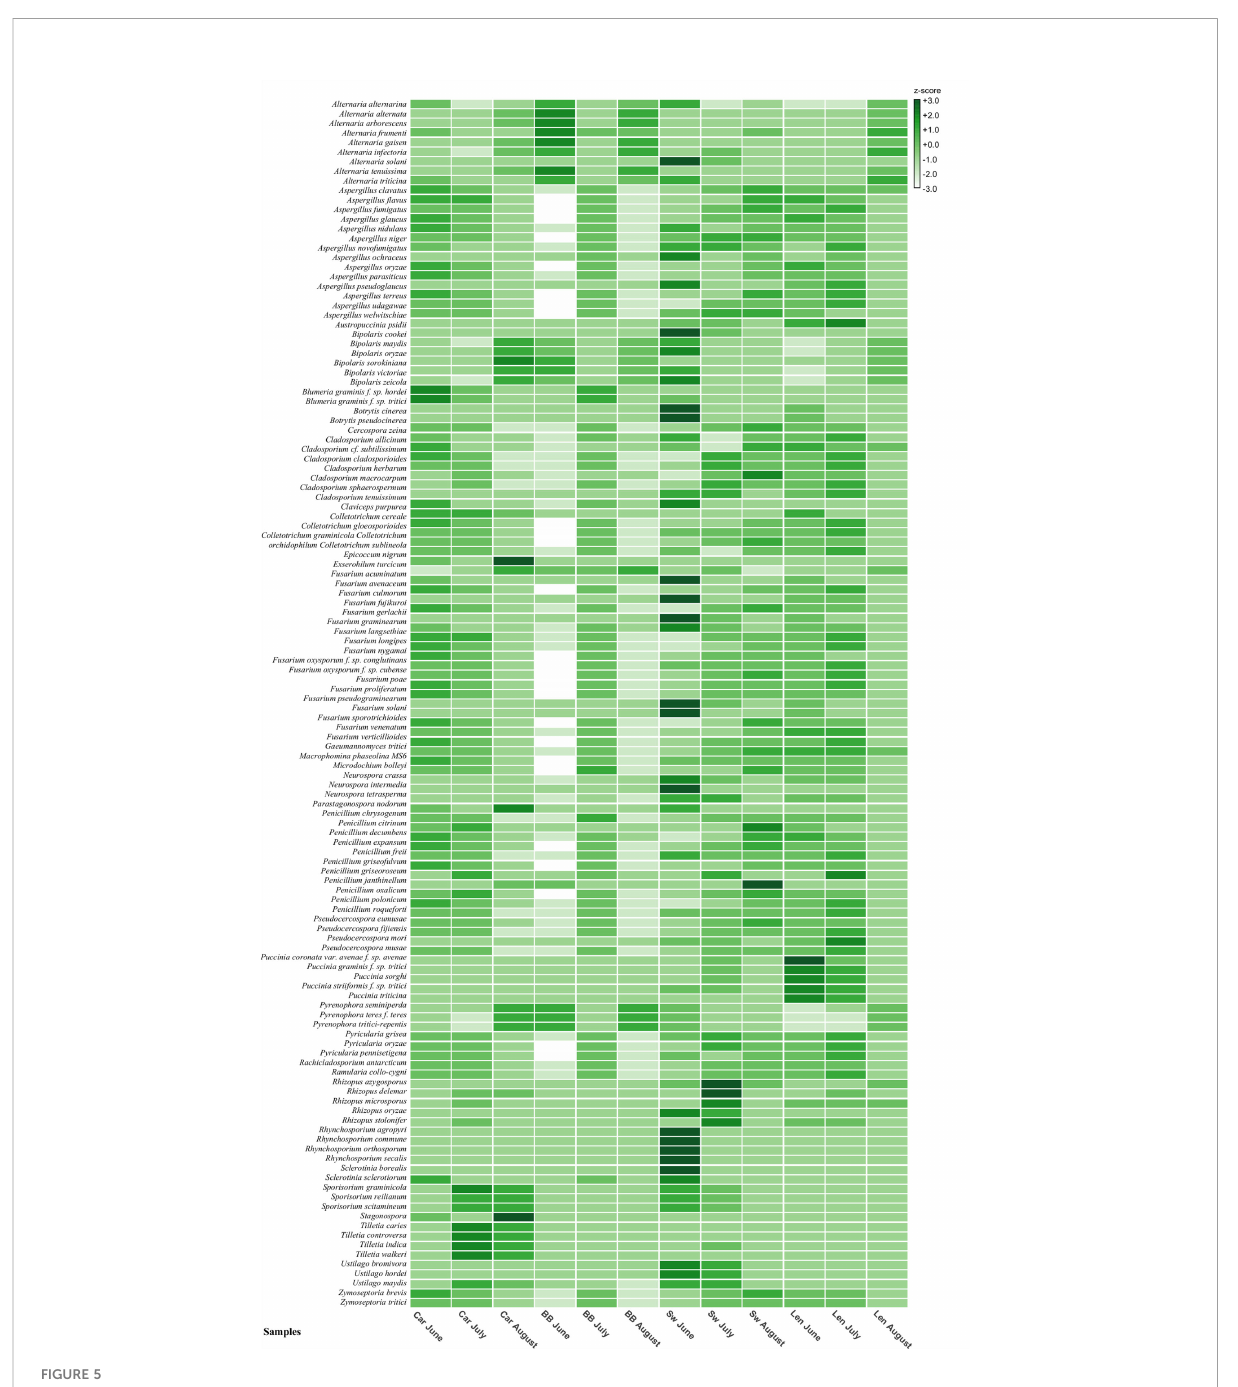
FIGURE 5 Heat map built in MEGAN 6 summarizing the 150 cereal fungal pathogens species hits recognized by BLAST metagenomic analysis. Species names are on the left-hand side of the map and fi eld site samples names are located on the bottom. Z-scores range: +3/-3. Car, Carnoustie; BB, Bishop Burton; SW, Swindon; Len,